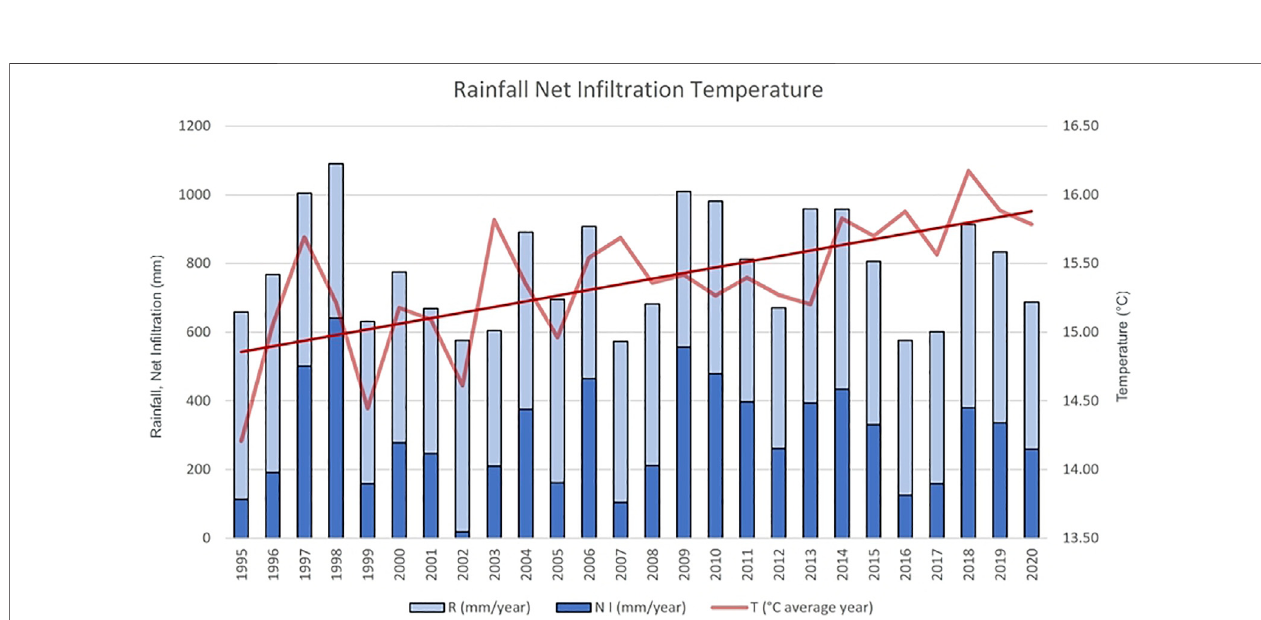
FIGURE 7 | Cumulated annual rainfall R (mm/y), net in fi ltration NI (mm/y), and average annual temperature T ( ° C) calculated for the Average Station in the 1995 – 2020 monitoring period.